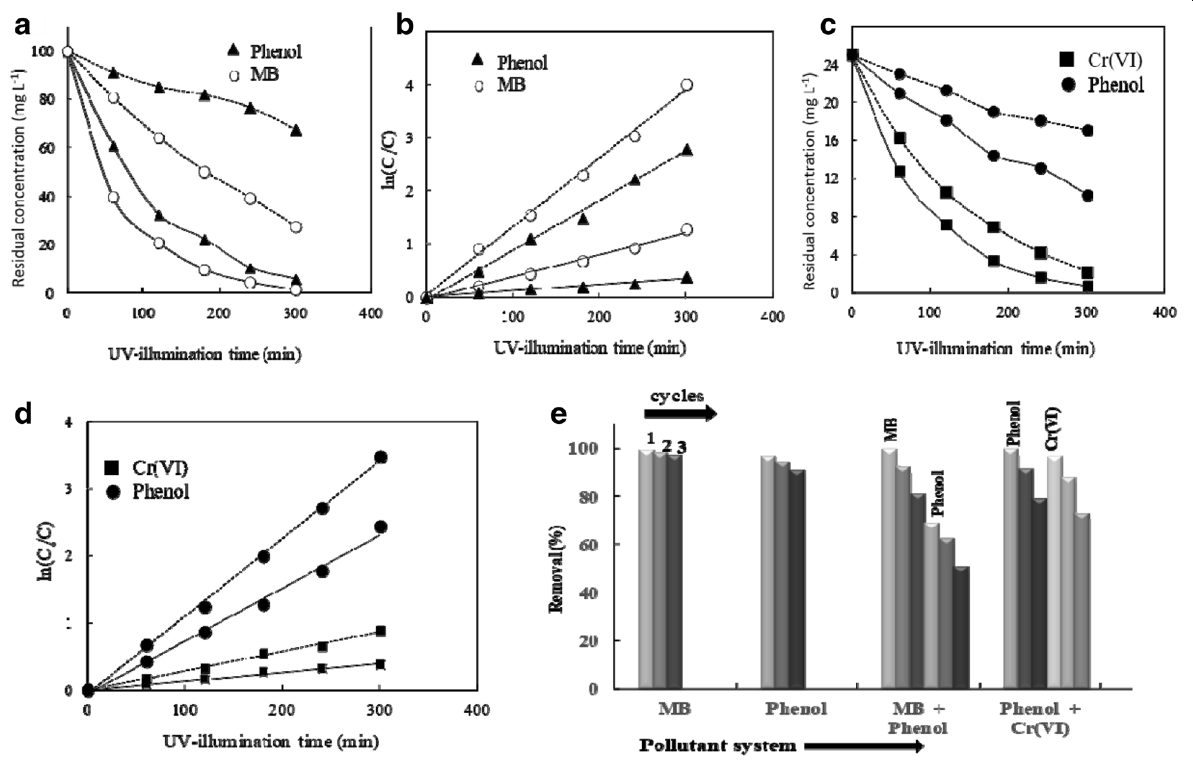
Fig. 4 ( a , c ) Variation of residual concentration with time and ( b , d ) corresponding Langmuir-Hinshelwood plot for photocatalytic oxidation between ( a , b ) phenol and MB ( c , d ) phenol and Cr(VI) by Photo-Zn-Bent. Dotted line represents a bi-component photocatalytic system and solid line presents single component system. ( e ) Repeated use of Photo-Zn-Bent for pollutant removal from consecutive three cycles from both single component (MB, Phenol) and bicomponent (MB-Phenol and Phenol-Cr(VI)) pollutant